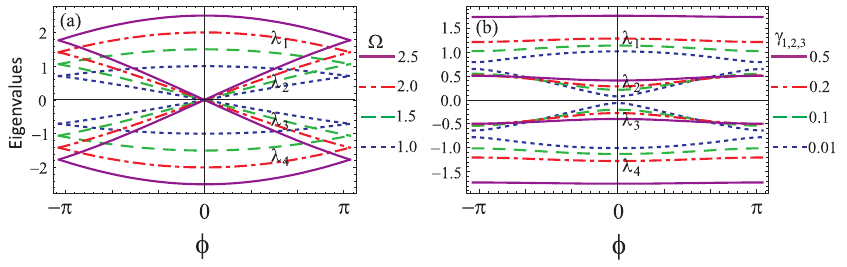
Figure 3. (Color online) The dressed energy eigenvalues λ i versus φ are shown in the panel (a) without the atomic dephasing, for Ω O 1 = Ω O 2 = Ω m 1 = Ω m 2 = 1 γ, 1 . 5 γ, 2 γ, 2 . 5 γ . (b) Here the atomic dephasings γ i = 1 , 2 , 3 are considered to be in the rate 0 . 01 γ (blue dotted), 0 . 1 γ (dashed green), 0 . 2 γ (doted-dashed red), 0 . 5 γ (solid blue), and Ω O 1 = Ω O 2 = Ω m 1 = Ω m 2 = 1